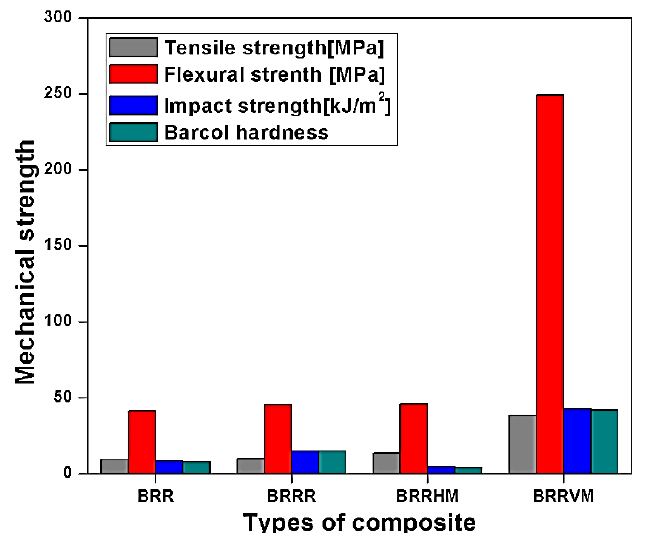
Figure 23. Mechanical properties of different orientation forms of banana ribbon-reinforced polyester composites.